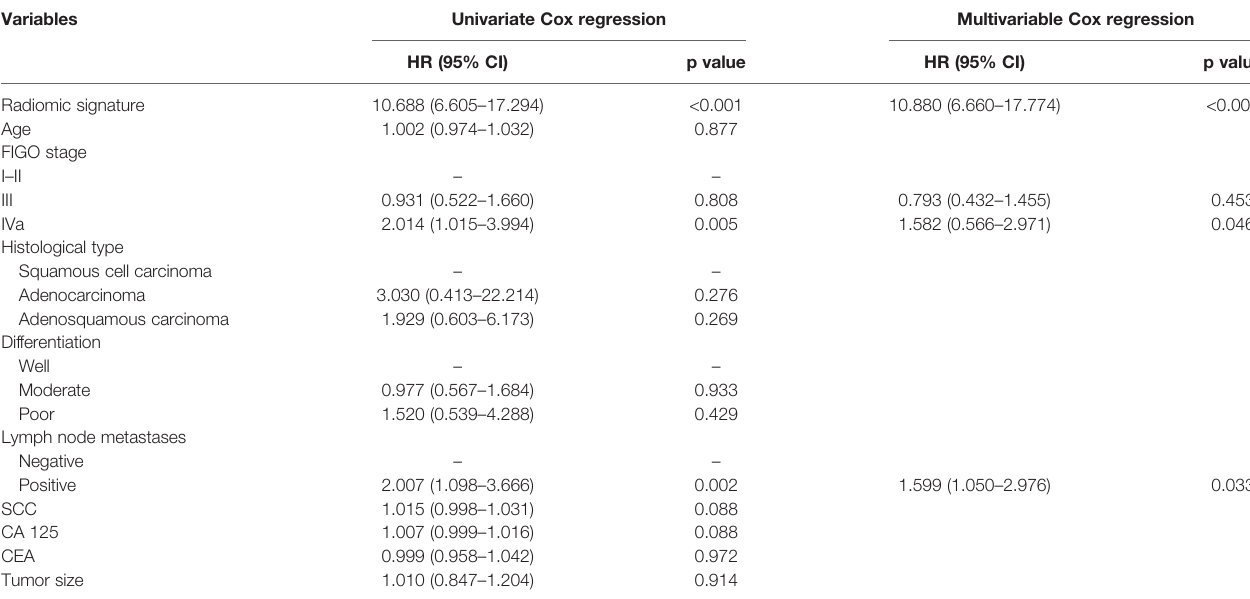
FIGO, Federation of Gynecology and Obstetrics; SCC, squamous cell carcinoma antigen; CEA, carcinoembryonic